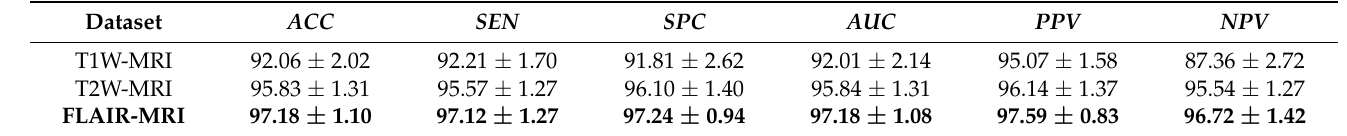
Table 12. Average performance of six models for each dataset.